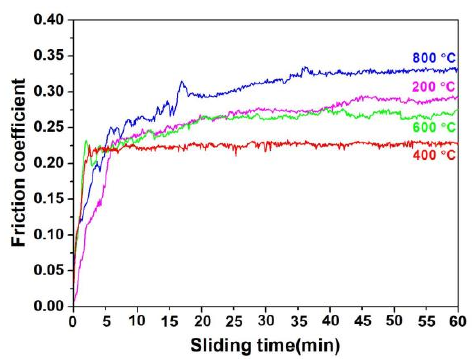
Figure 5. Dynamic friction coe ffi cients of NST varying with the sliding time at 200, 400, 600 and 800